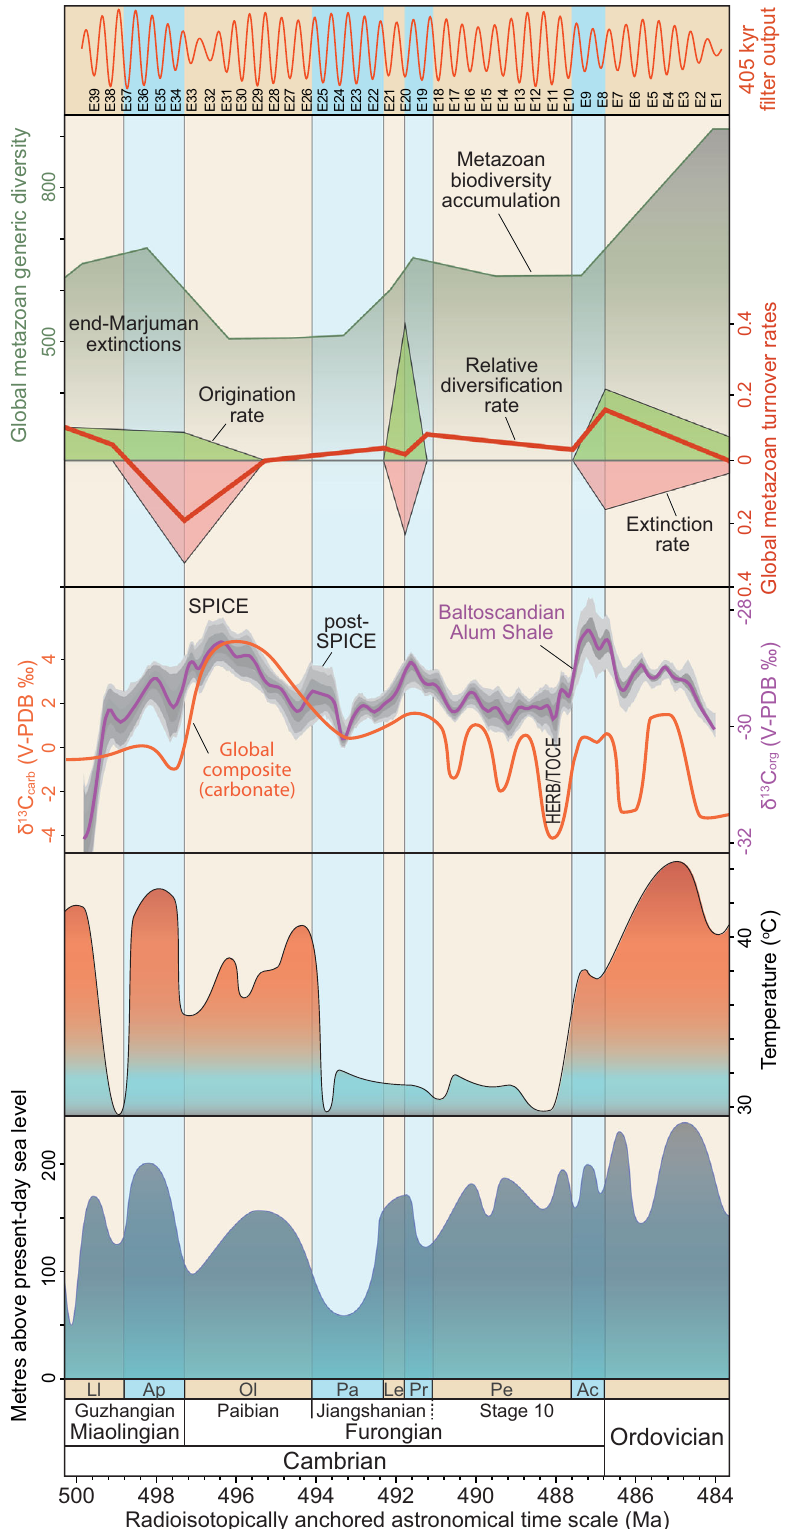
Fig. 5 Temporal correlation of late Cambrian – earliest Ordovician biotic and abiotic events calibrated to the Baltoscandian radioisotopically anchored astrochronological framework. Elevated extinction rates coincide with extreme heat and high sea level, whereas the rapid Jiangshanian rebound occurs at ~492 Ma while temperatures were lower. Generic richness data based on refs. 5,88 ; δ 13 C org data from the Albjära-1 core in this study and δ 13 C Carb curve from GTS2020 49 . Temperature data based on ref. 74 with blue shading denoting the current tropical sea surface temperature range, red above that window. Sea-level curve adopted from ref. 5 . The base of Stage 10 de fi ned as in Fig. 1. Blue and orange shaded intervals represent Scandinavian biozones as shown in Fig. 2 except the abbreviation Ac Acerocarina